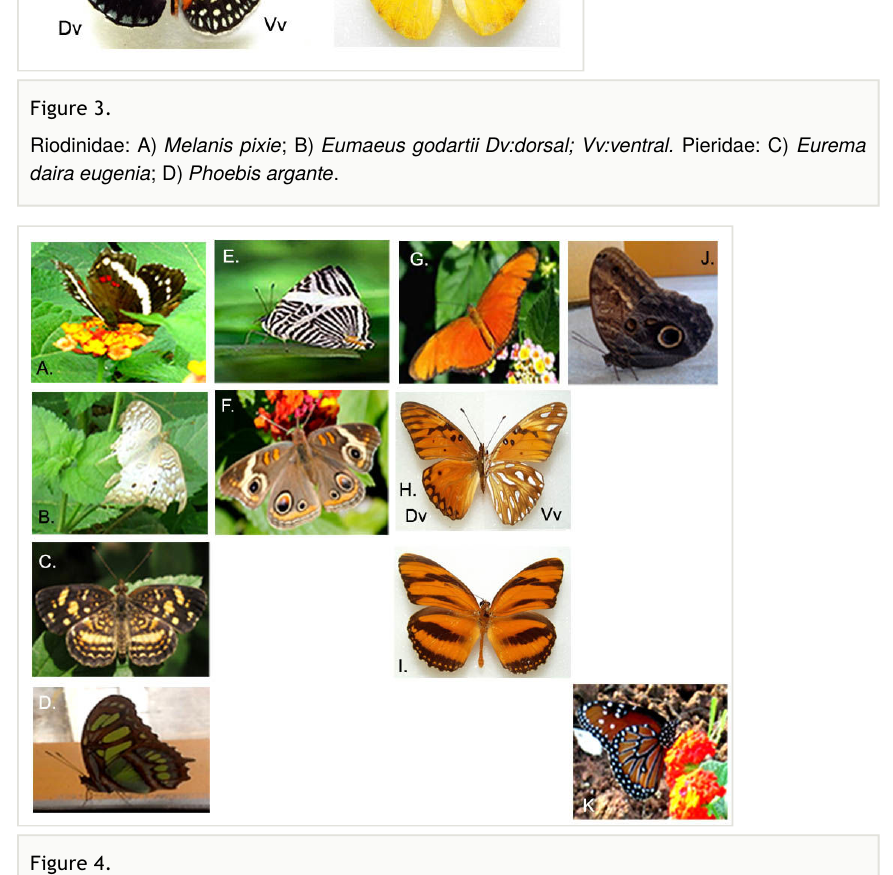
Figure 4. Nymphalidae. Nymphalinae: A) Anartia fatima ; B) A. jatrophae ; C) Anthanassa tulcis ; D) Siproeta stelenes ; E) Colobura dirce ; F) Junonia evarete. Heliconiinae: G) Dryas iulia ; H) Agraulis vanilla ; I) Dryadula phaetusa. Morphinae: J) Caligo atreus ; Danainae: K) Danaus gillipus